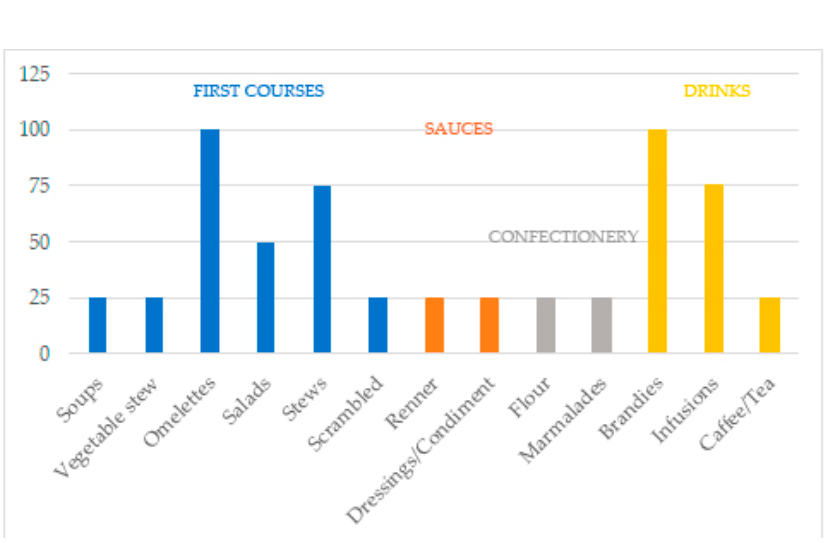
Figure 5. Culinary elaborations according to the percentage of interviewees that mentioned them.